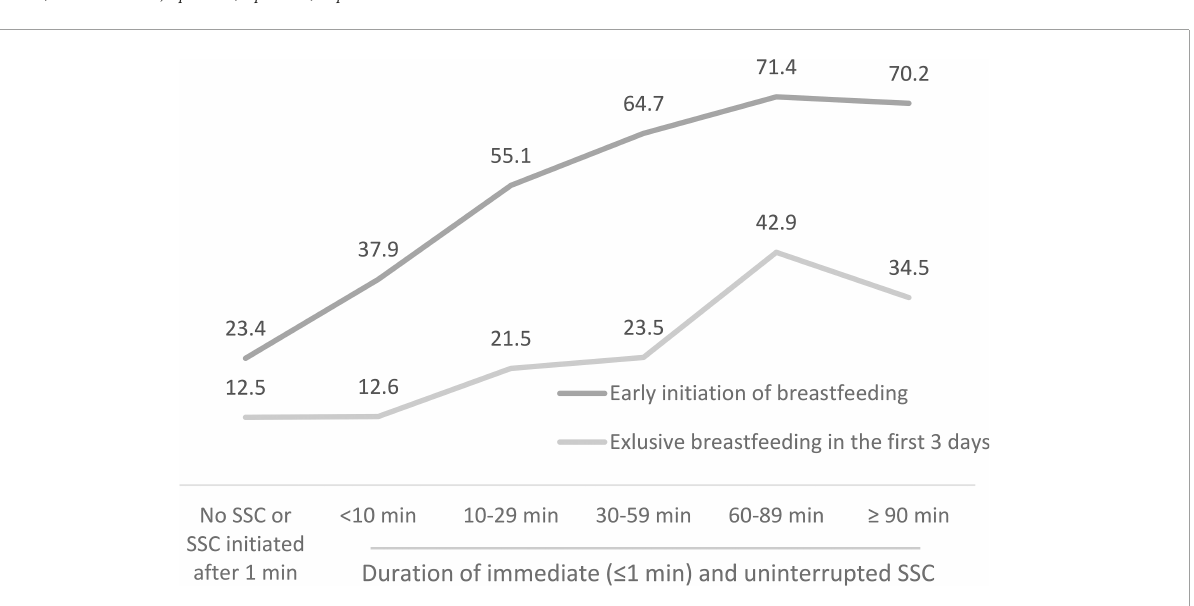
FIGURE1 Skin-to-skin contact (SSC) and breastfeeding practices reported by mothers of infants 0–11 months, three provinces, Vietnam,